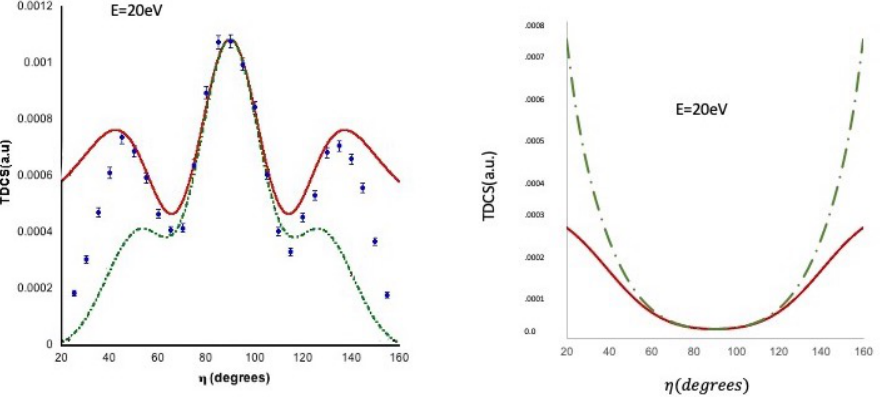
Figure 10. TDCS for electron ( left panel ) and positron impact ( right panel ) ionization of helium in the perpendicular plane ( Φ = 90 ◦ ), E 0 = 64.6 eV, experimental points [31]. The theoretical curves are: solid red curve: DWBA with no pci; green dashed dotted DWBA with